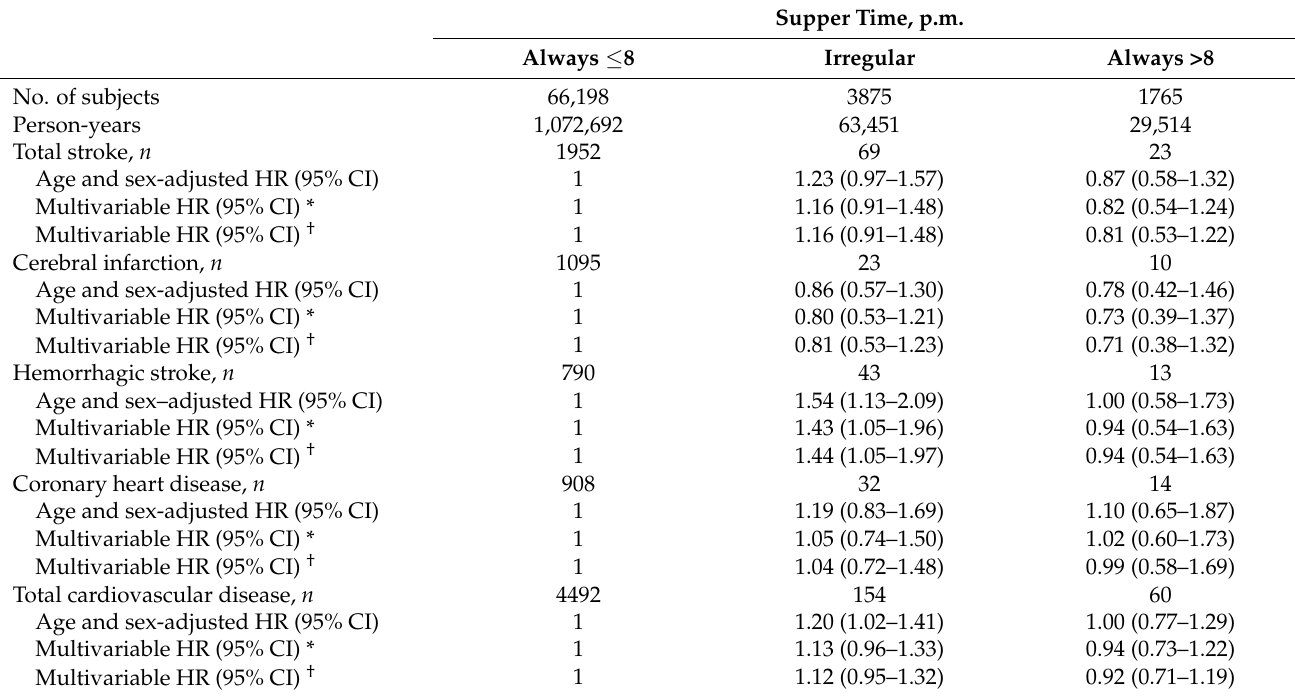
Table 2. Hazard ratios (HRs) and 95% confidence intervals (CIs) for cardiovascular mortality outcomes according to supper time.